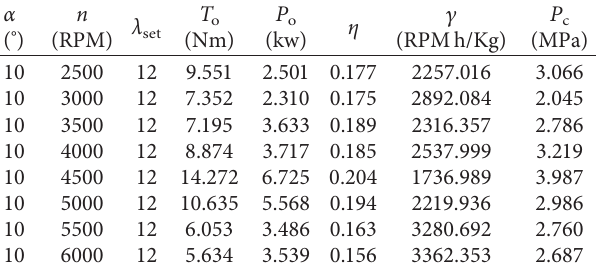
Figure 9: Air mass flow and cylinder pressure compare curves. (a) Air mass flow at different engine speeds. (b) Cylinder pressure when engine speed is 5000RPM. Table 2: Results of the GT-power simulation when α � 10 ° .